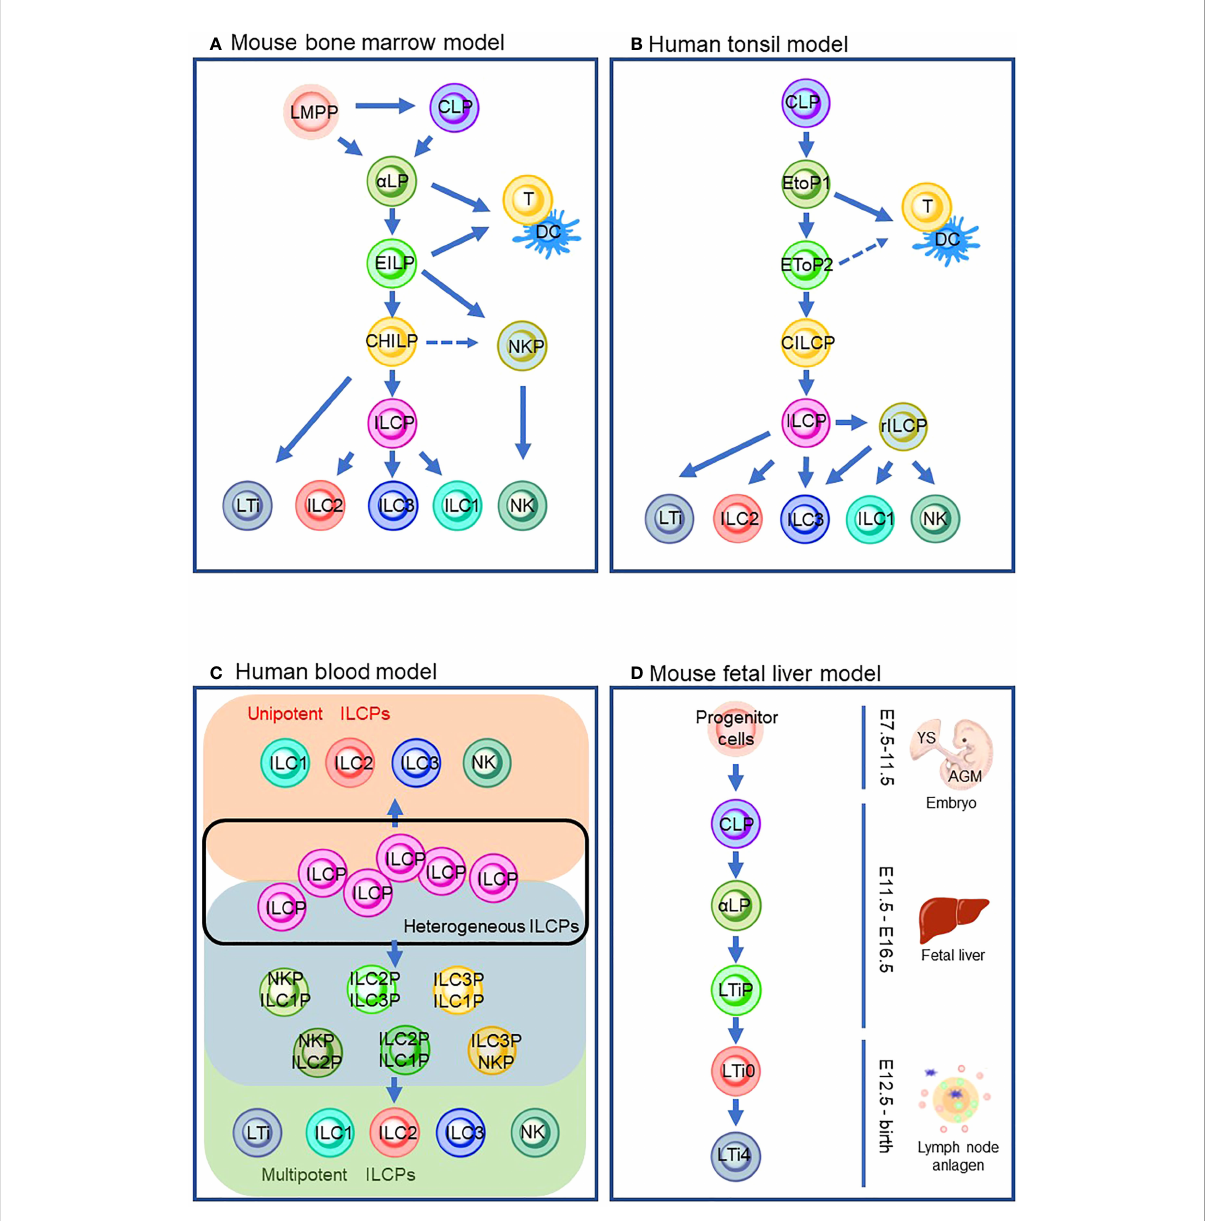
FIGURE 1 ILC differentiation pathways in the different models that are currently proposed. (A) Mouse bone marrow model. (B) Human tonsil model. (C) Human blood model which describes the heterogeneous ILCP group (inside a black line), ILC subsets from unipotent ILCPs (orange background), and ILC subsets from multipotent ILCPs (green background) via its intermediates (blue background). (D) Mouse fetal liver model. Solid lines indicate the differentiation pathway which is considered the main pathway. Dashed lines indicate the alternative pathways that are demonstrated by the experiments in speci fi c conditions. LMPP: lymphoid primed multipotent progenitors; CLP, common lymphoid progenitor; a LP, a -lymphoid precursor cells; EILP, early inmate lymphoid progenitor; DC, dendritic cells; CHILP, common helper-like innate lymphoid progenitor; NKP, natural killer cell progenitor; ILCP, innate lymphoid cell progenitor; ILC1/2/3, group 1/2/3 innate lymphoid cell; NK, natural killer cell; LTi, lymphoid tissue inducer; EToP1/2, early tonsil progenitor 1/2; CILCP, common innate lymphoid cell progenitor; YS, yolk sac; AGM, aorta – gonad –